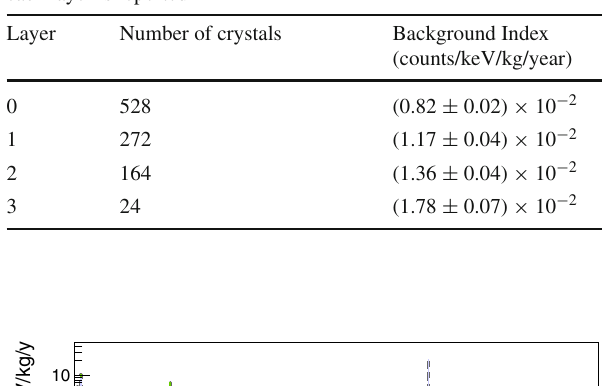
Table 9 Expected background indexes (statistical errors only) for the different layers of the CUORE tower array. The number of crystals in each layer is reported